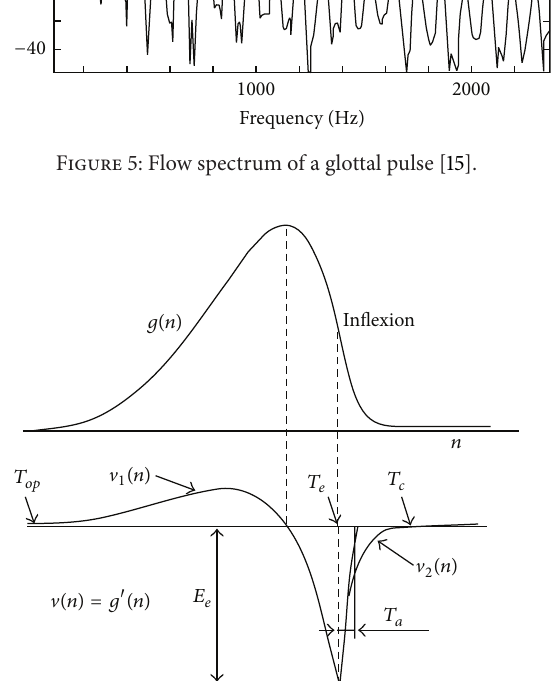
Figure 6: A typical approximation of glottal pulse (upper) and its derivative (lower)